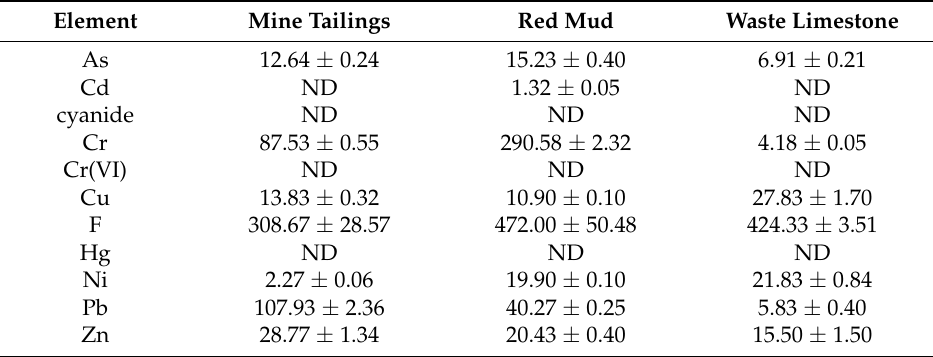
Table 2. Total concentrations of hazardous elements (As, Cd, cyanide, Cr, Cr(VI), Cu, F, Hg, Ni, Pb, and Zn) in the mine tailings, the red mud, the waste limestone (Unit: mg · kg − 1 ).